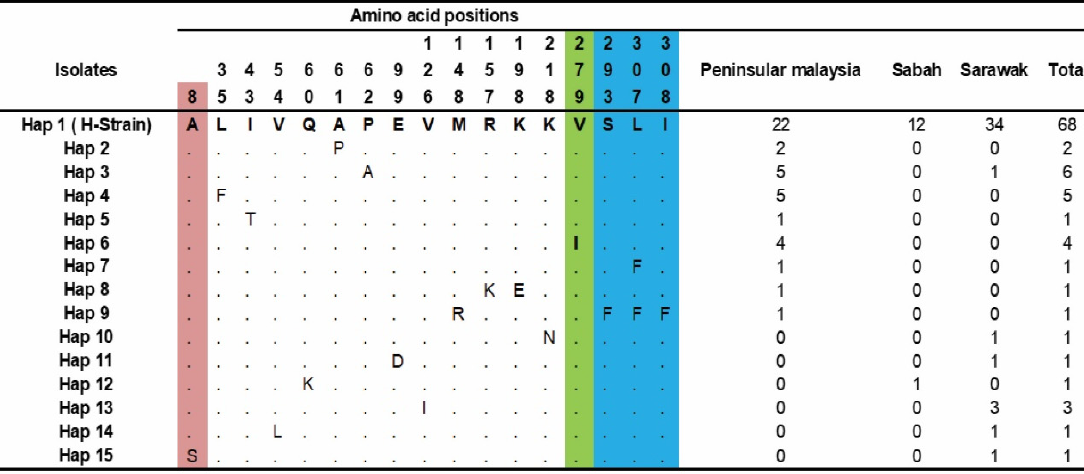
Figure 3. Amino acid haplotypes observed within PkTRAMP from Malaysian samples. Amino acids identical to reference strain H (PKNH_1436700) are indicated in the top row Hap 1. The maroon color indicates the SP domain, green color indicates the TSR domain and blue color indicates the TM domain. Total number of haplotypes indicated in right panel. Dots represent identical amino acid, and the numbers in vertical represent the position of the amino acids with respect to the H- strain.